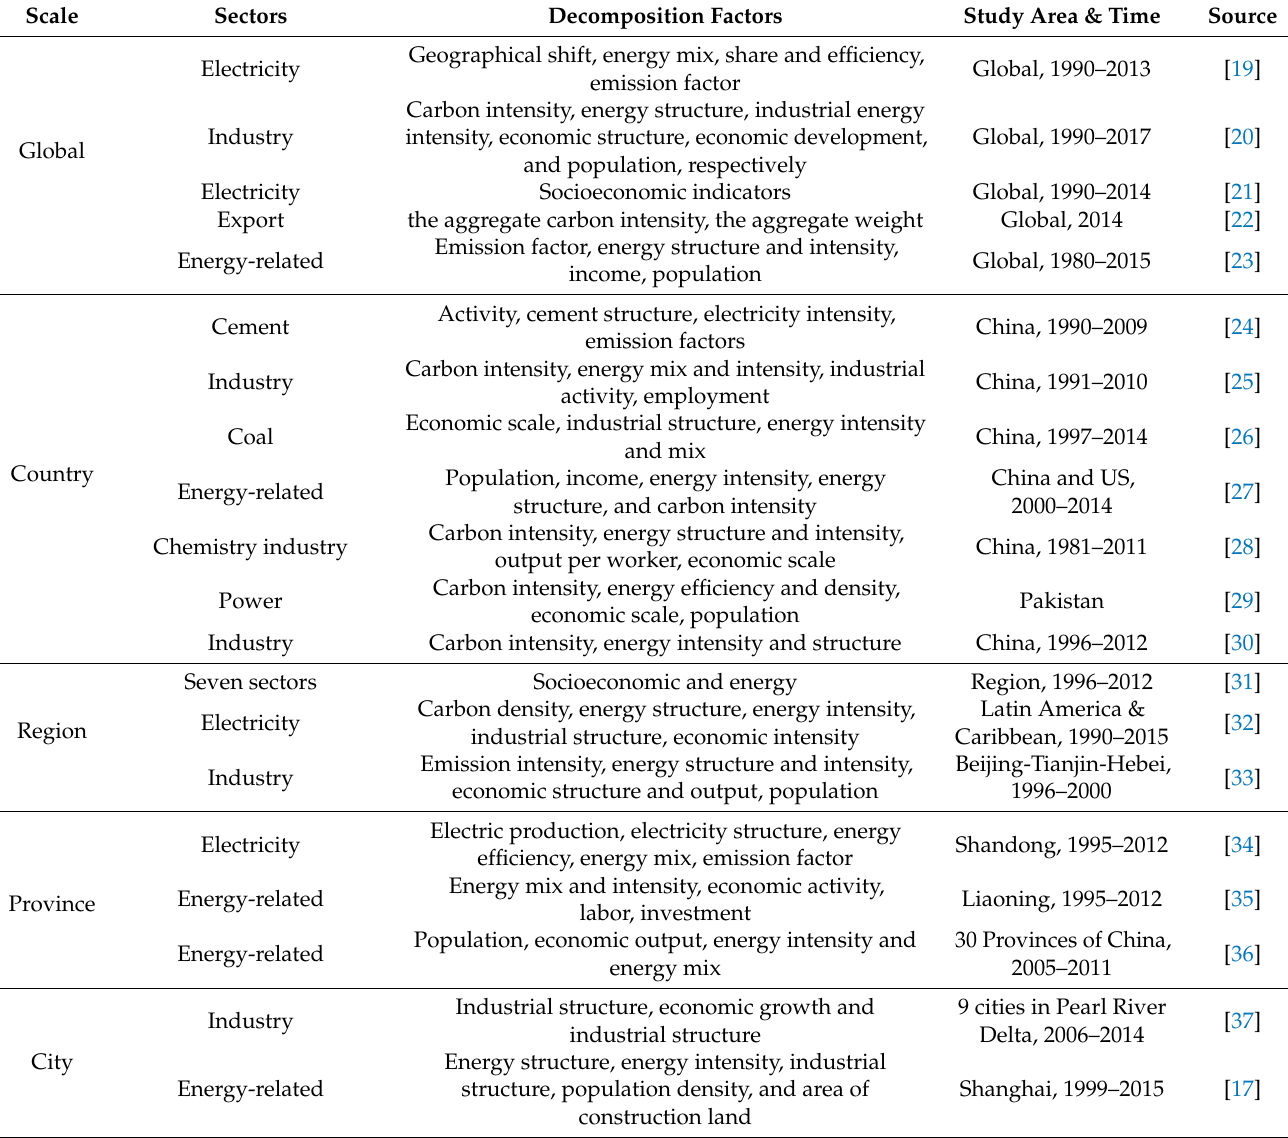
Table 1. Decomposition of CEs changes in existing